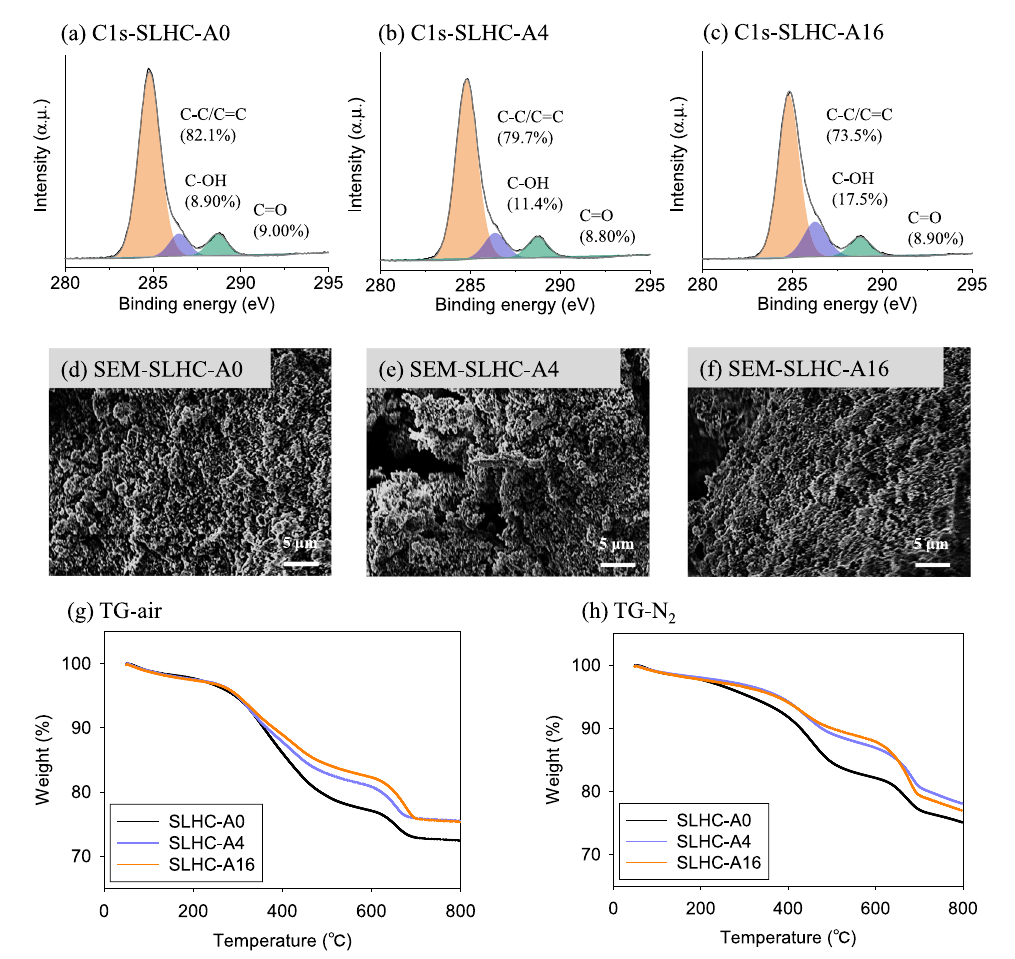
Fig. 2 C1s X-ray photoelectron spectroscopy (XPS) spectra, scanning electron microscope (SEM) images, and thermogravimetric (TG) pro- files of fresh and aged hydrochars. The peaks with the binding energy of 284.8, 286.1, and 288.0 eV are assigned to the carbon atoms in aromatic rings (C–C/C=C), hydroxyl (C–OH), and carbonyl (C=O),